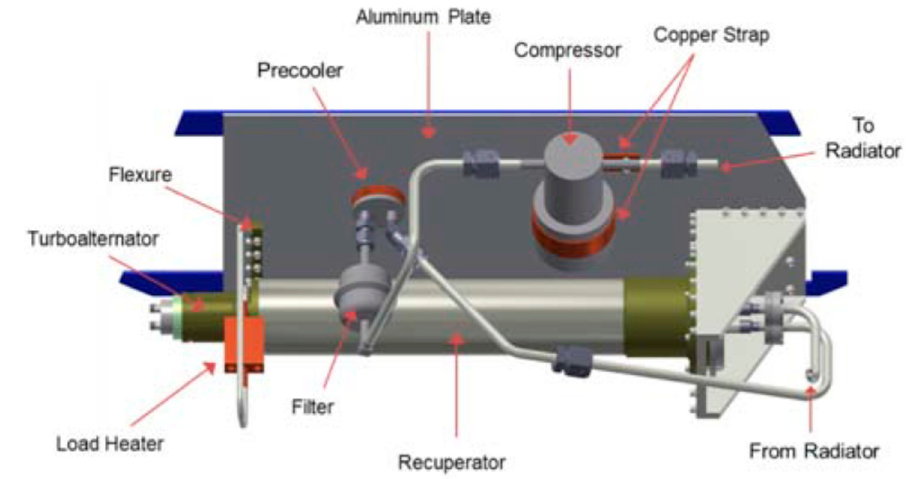
Figure 26. Mechanical Cryo-Cooler Configuration [23].